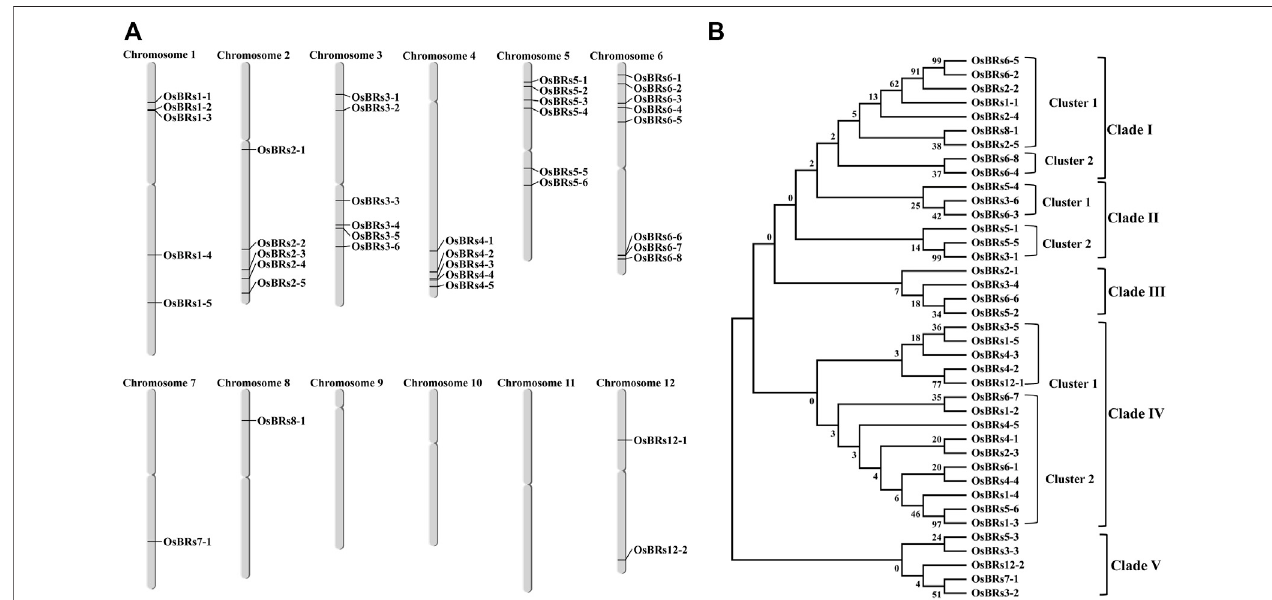
FIGURE 2 | (A) Graphical representation of the chromosomal distribution of the 39 promoter sequences of the BR signaling genes in rice. (B) Phylogenetic relationshipofthe1.5 kbupstream promotersequencesofthe39BRgenes.ThesequenceswerealignedusingClustalOmega,andthetreewasconstructedbyMEGA 7 using the neighbor-joining method.